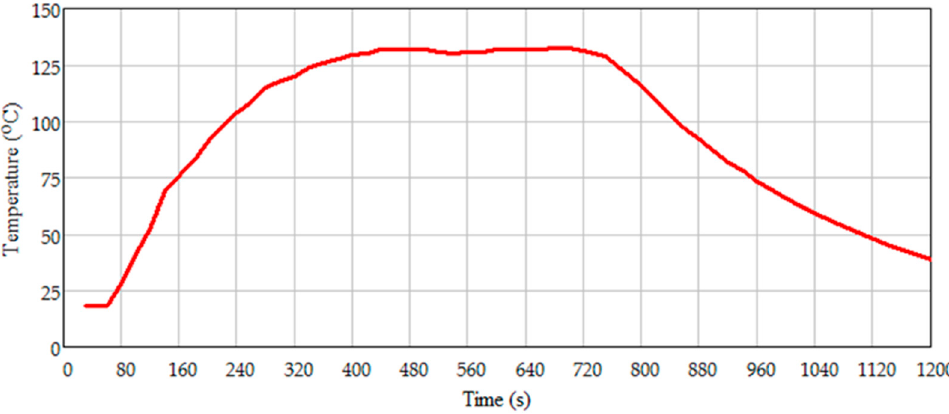
Figure 5. Time variation of the maximum temperature on the convex face of the second shield.